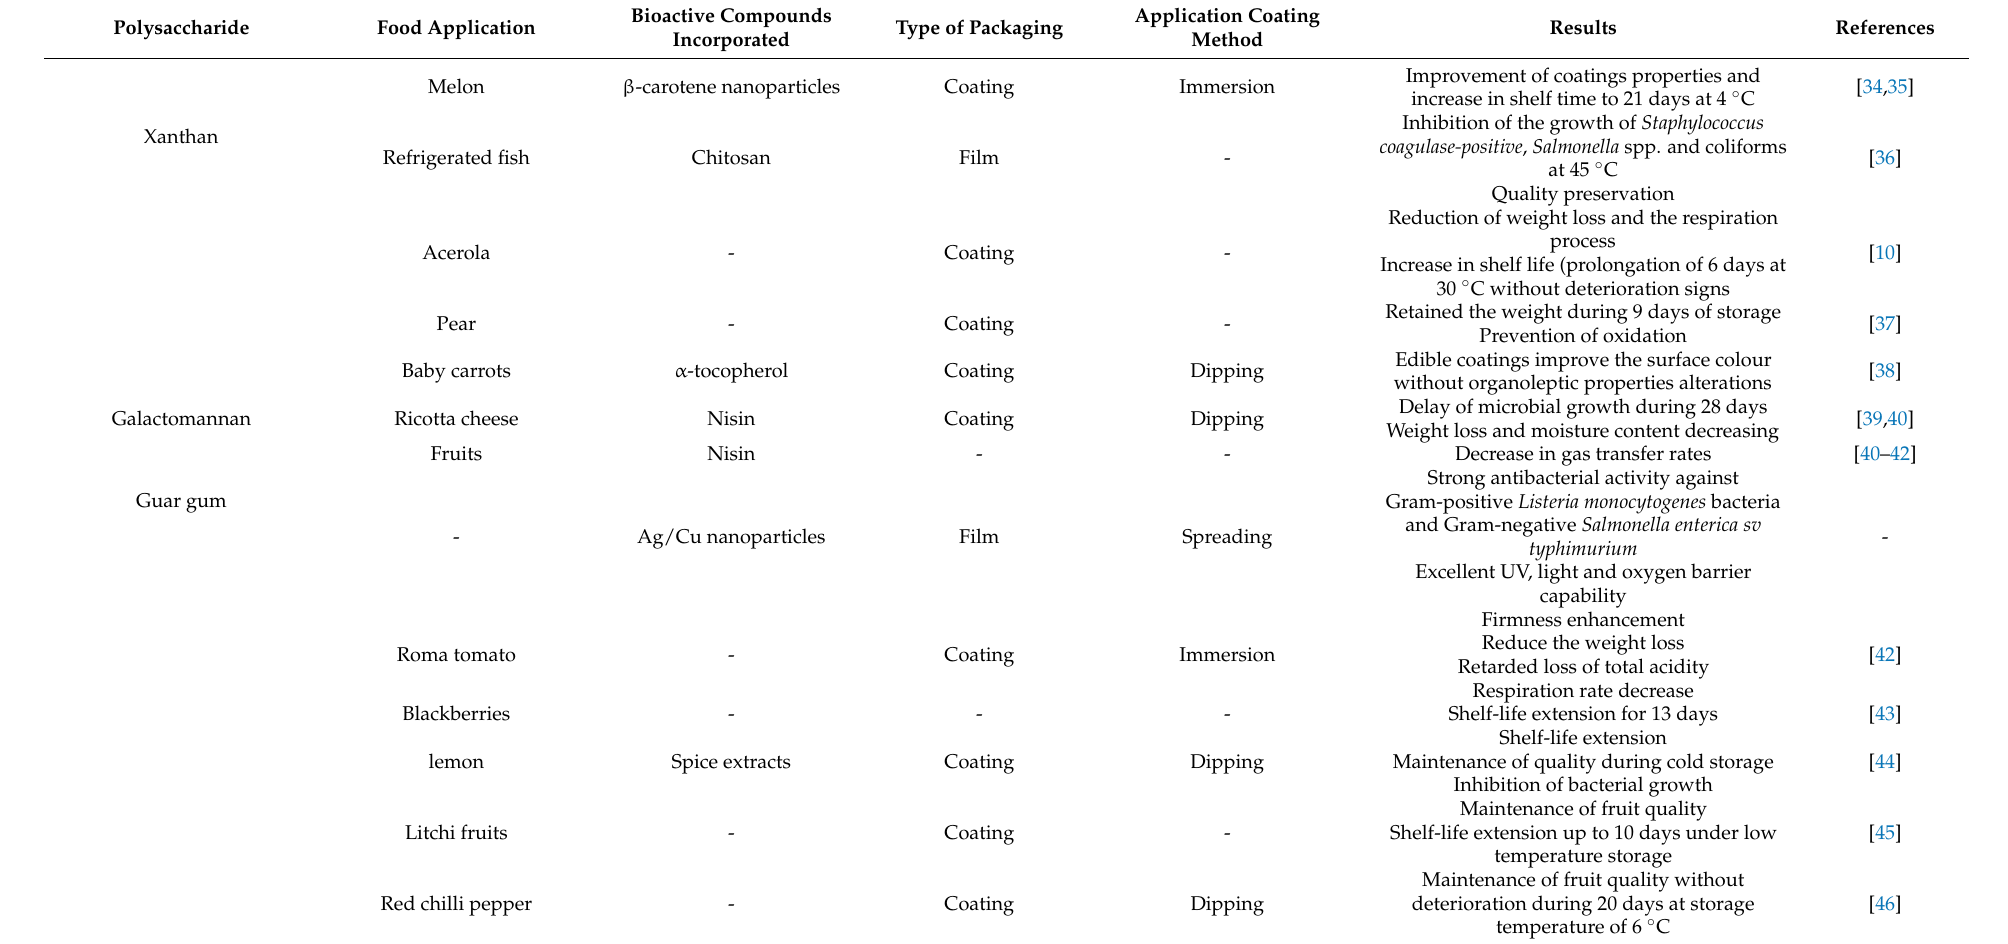
Table 1. Gums coatings and films with or without incorporation of bioactive compounds and their properties as food